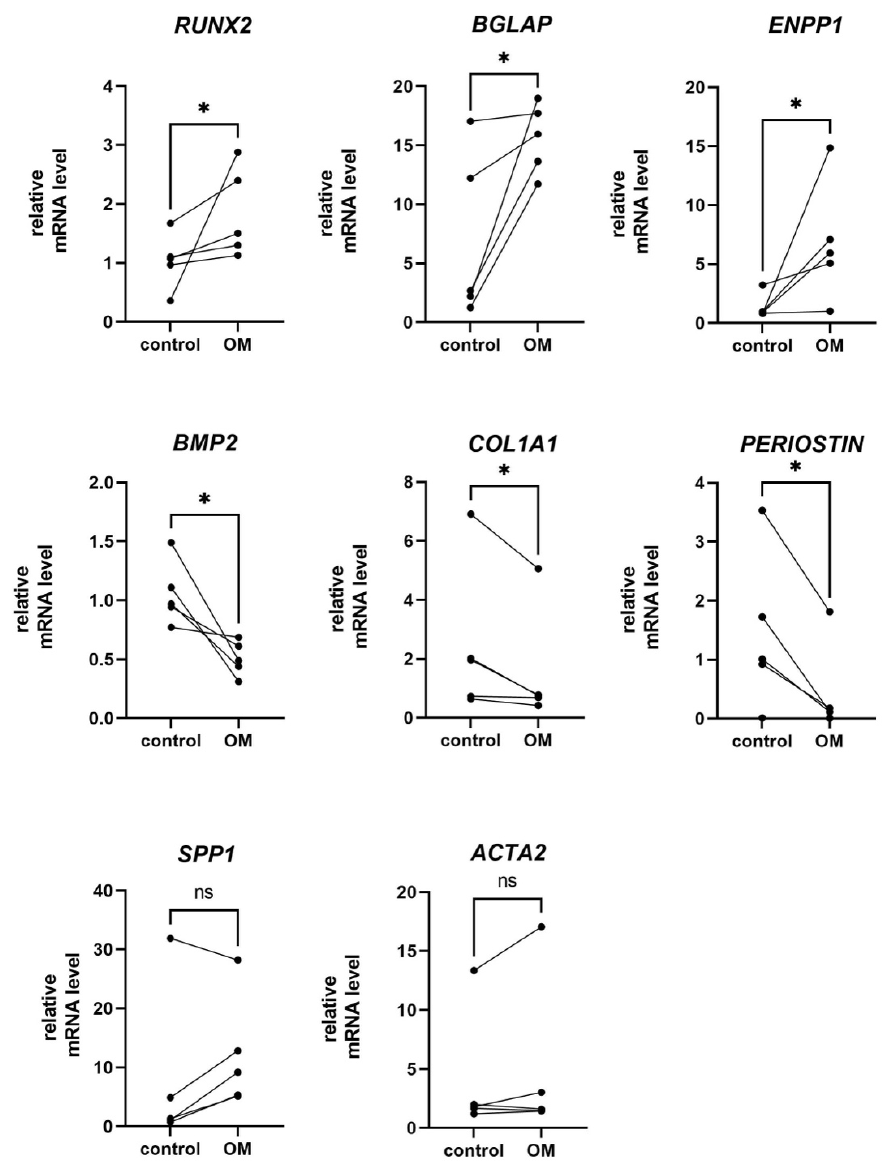
Figure 5. OB cells phenotype characterization by qPCR in control conditions and 96 h of differ- entiation in osteogenic medium (OM). OB cells from all tested donors showed a similar response to osteogenic medium, while relative mRNA levels both in control and experimental conditions vary from donor to donor. * p ≤ 0.05, ns-non significant.